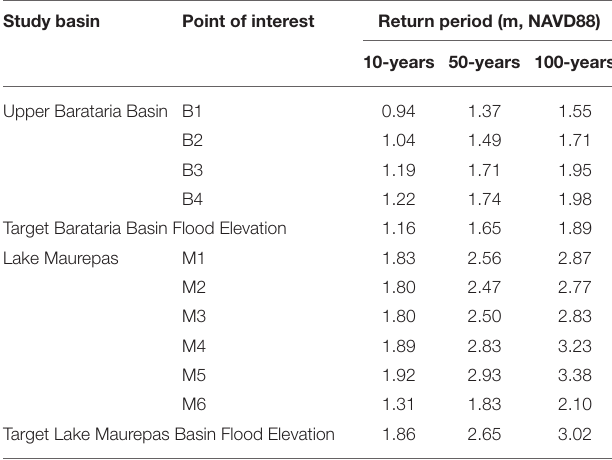
TABLE 1 | Return period stillwater elevations (m, NAVD88) for the points of interest. Study